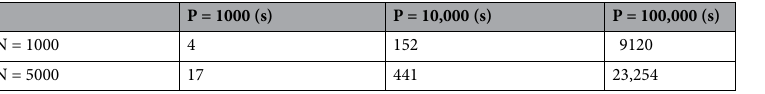
Table 1. Assessment of running time (shown in seconds) for Nebula using simulated datasets of varying sizes. N is the number of samples and P is the number of